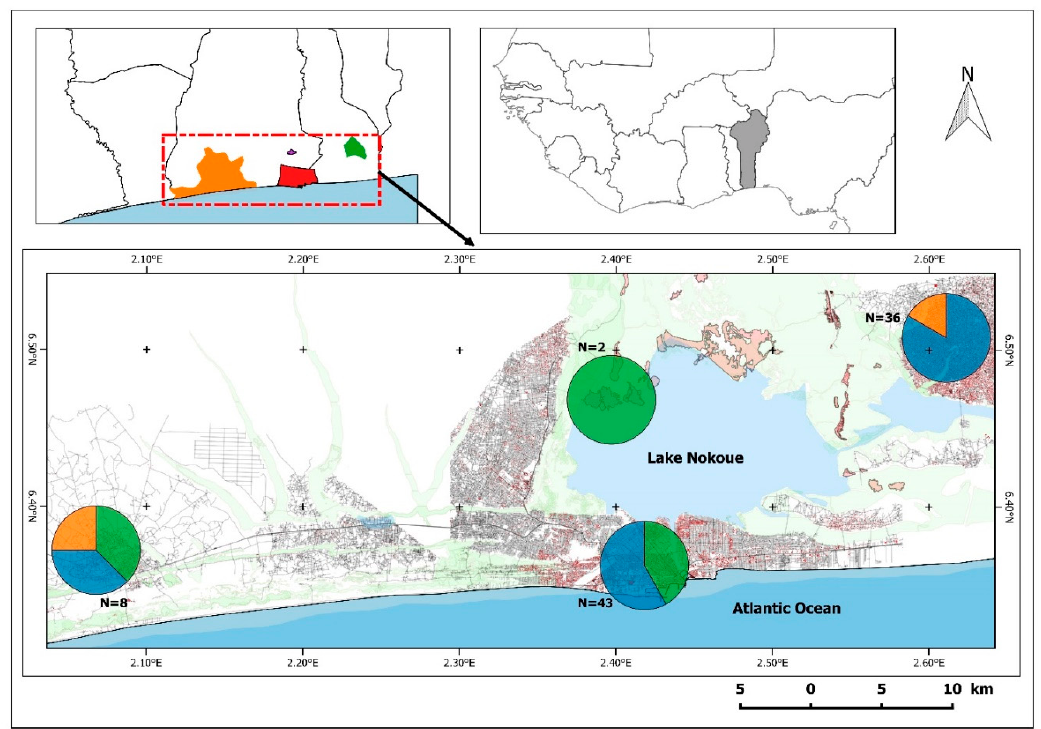
Figure 3. Relative frequencies of the various Leptospira species (as identified through 16S sequencing) in the four studied zones. Orange, blue, and green correspond to L. kirschneri , L. borgpeterseni , and L. interrogans , respectively. N indicates the number of sequences retrieved for each geographic zone (see also Table 2).